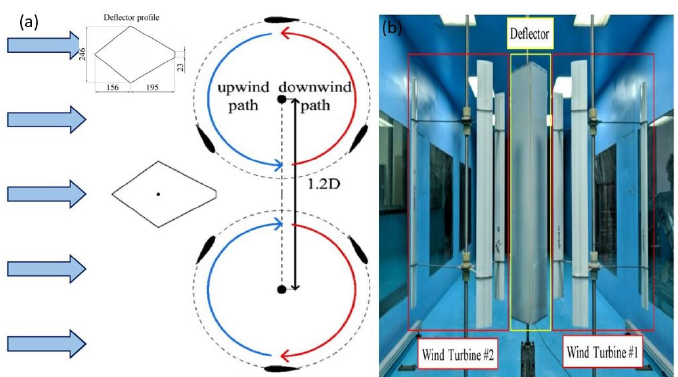
Figure 11. A kite-shaped wind deflector installed upstream of the VAWT. ( a ) Design. ( b ) Experimental test setup (adapted from [81]).